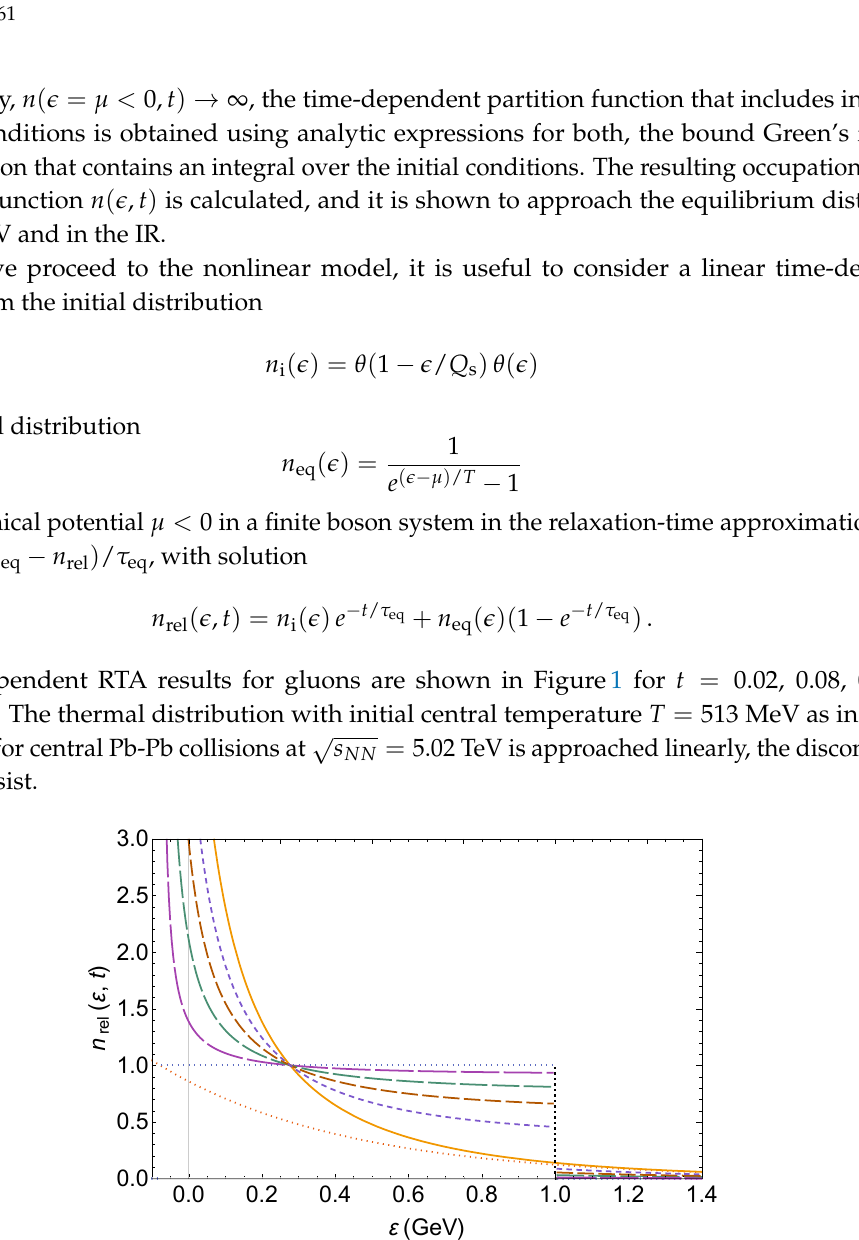
Figure 1. Local thermalization of gluons in the linear relaxation-time approximation (RTA) for µ < 0. Starting from schematic initial conditions Equation(13) in the cold system at t = 0 (box distribution with cut at (cid:101) = Q s = 1 GeV), a Bose–Einstein equilibrium distribution with temperature T (cid:39) 513 MeV (solid curve) is approached. Time-dependent single-particle occupation-number distribution functions are shown at t = 0.02, 0.08, 0.15, 0.3, and 0.6 fm/ c (decreasing dash lenghts). The lower dotted curve is Boltzmann’s